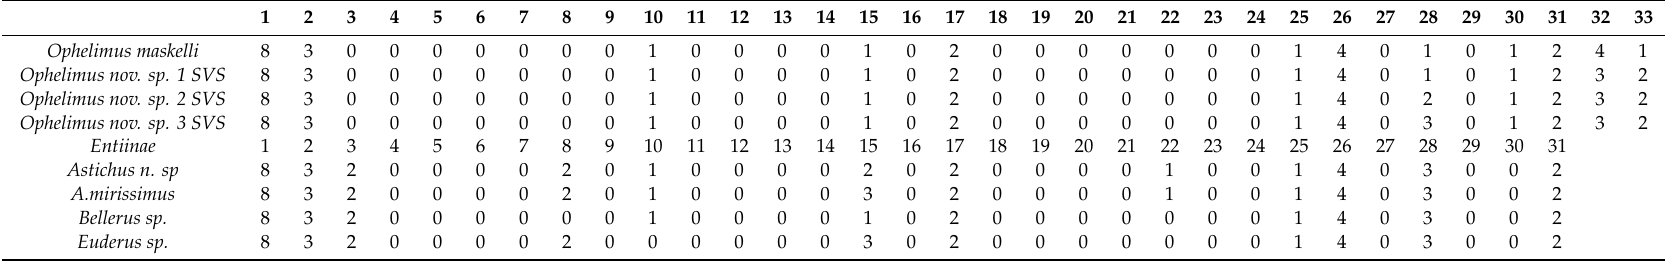
Table 4. Result of the morphological characterization of Ophelimus migdanorum nov sp. in Chile, according to Burks [10] and comparison to other members of Ophelimini and Entiinae. Keys 32 and 33 are additional and highly discriminatory characteristics according to Protosov